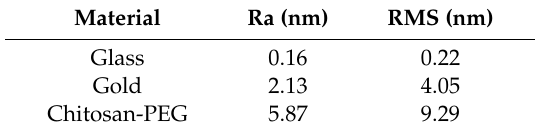
Table 1. Roughness parameters for the glass, gold, and the chitosan-PEG film surfaces.